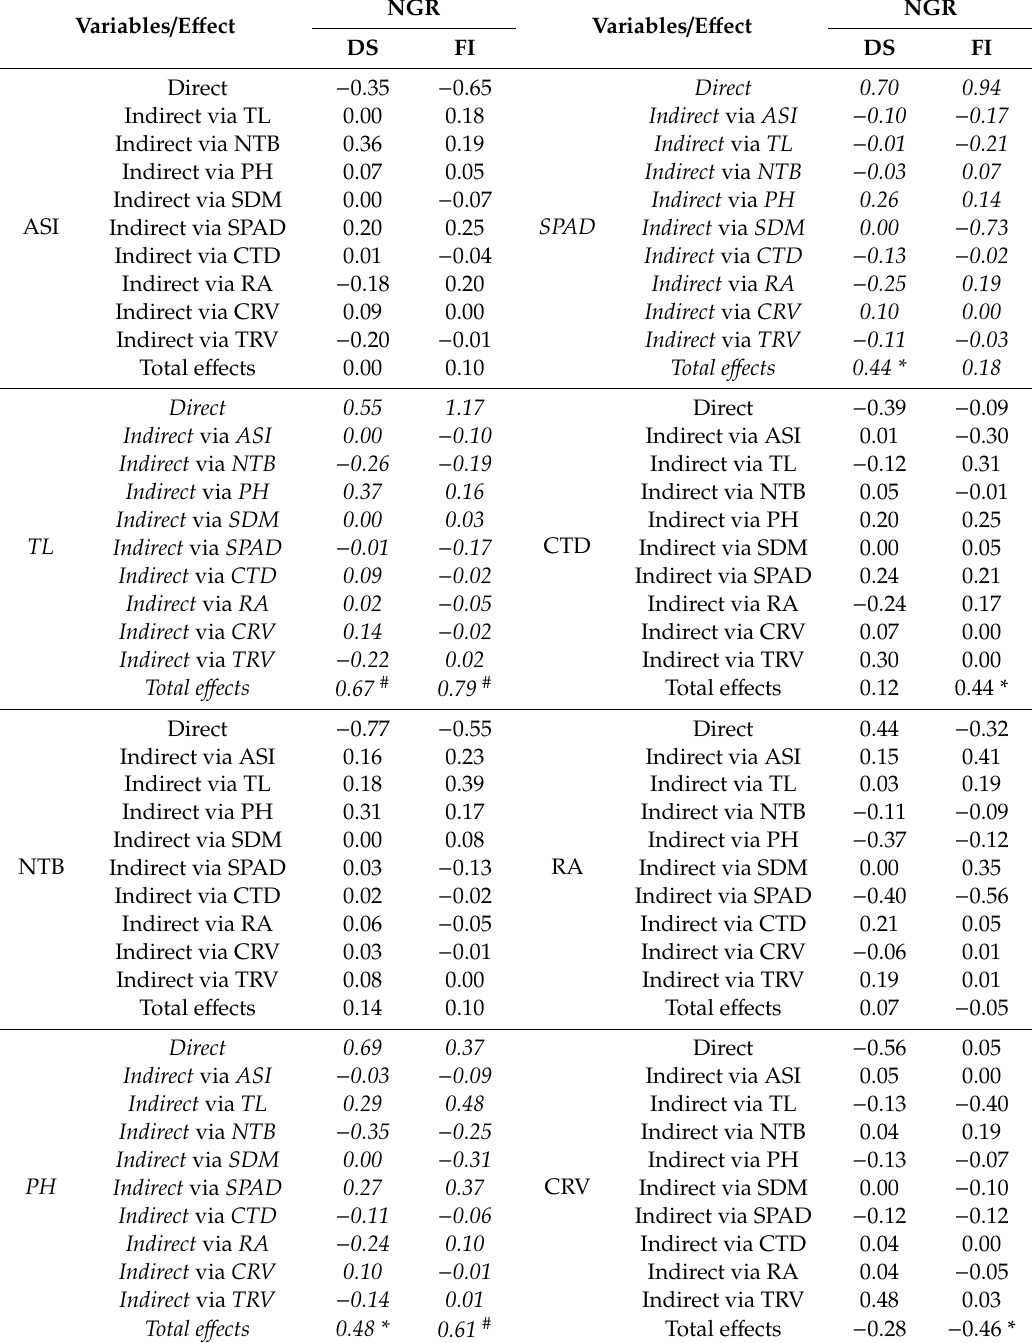
Table 3. Pathway analysis of the partitioning of the genotype correlations in components of direct and indirect e ff ects obtained between first-order agricultural traits and second- order morphological, physiological and root traits evaluated in popcorn lines under FI and